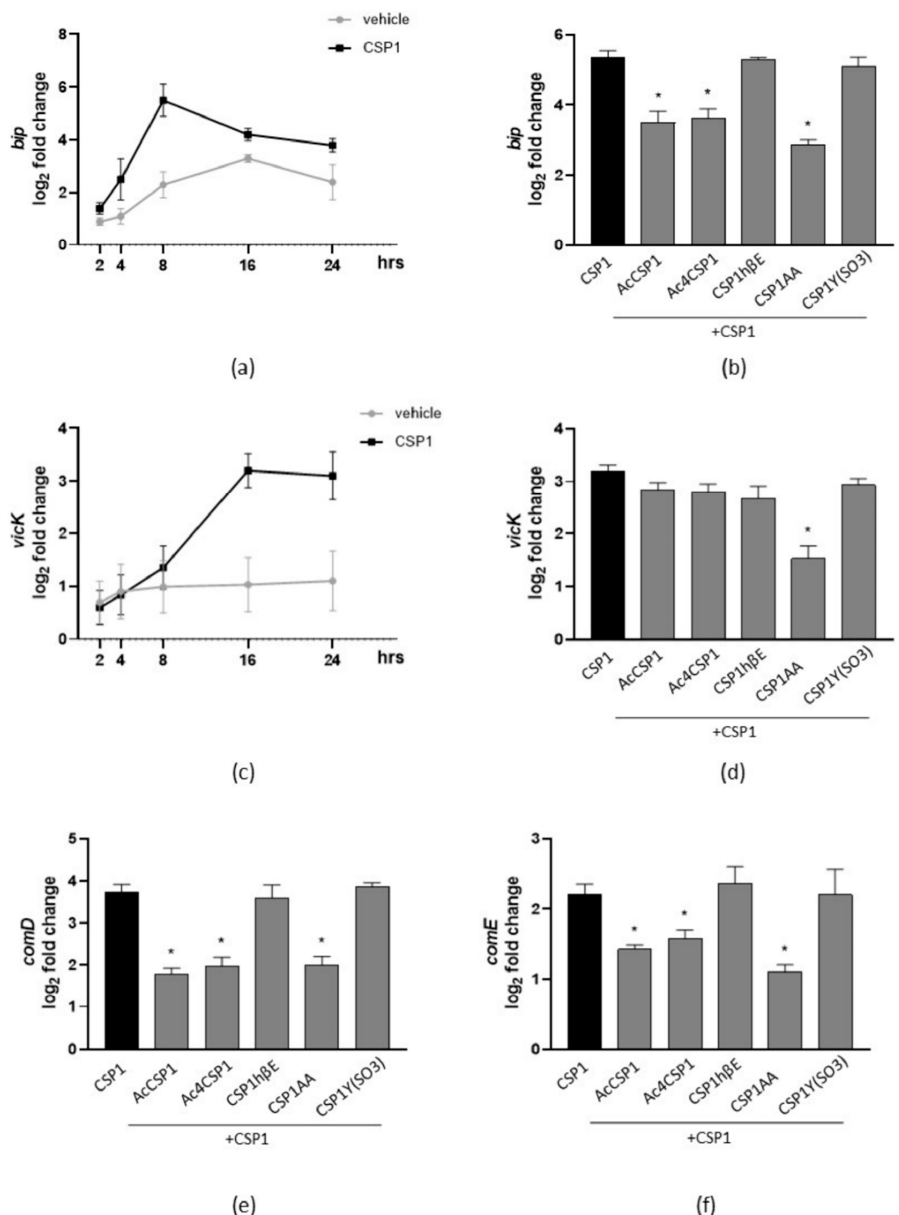
Figure 4. Effects of synthesized peptides on QS-related gene expression. ( a ) Cultures of S. mutans were incubated with the vehicle or CSP1 (20 μ M) for 2–24 h. Bacteria were collected and subjected to RNA extraction. Expression of the bip gene was investigated by qPCR. ( b ) Cultures of S. mutans